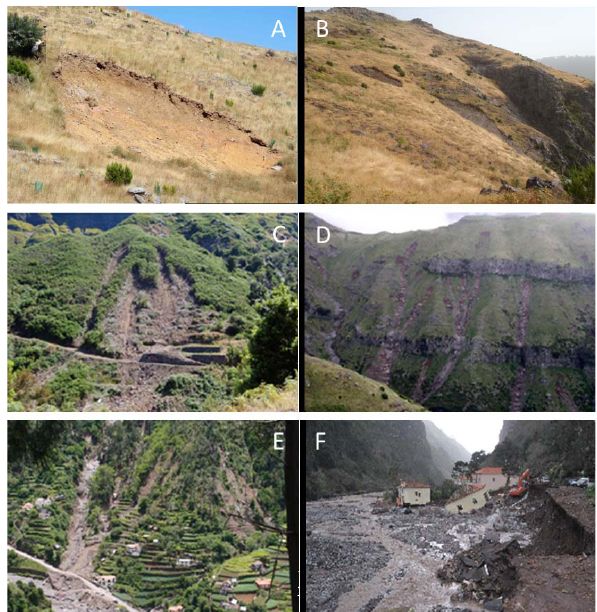
Fig. 2. Shallow landslides trigged during the 2010 event: (A) and (B) – soil-slips; (C) , (D) , and (E) – soil slip-debris flows; (F) – material